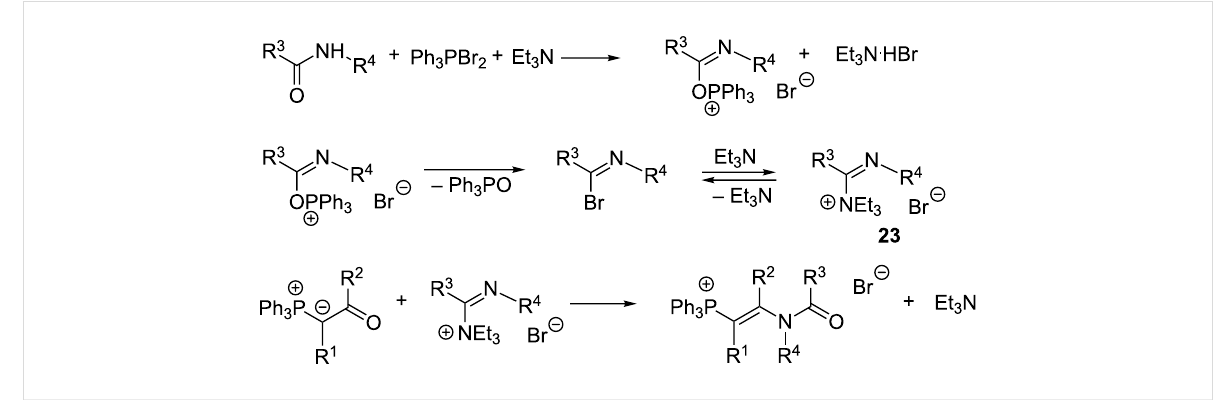
Scheme 16: Imidoylation of β -carbonyl ylides with imidoyl halides generated in